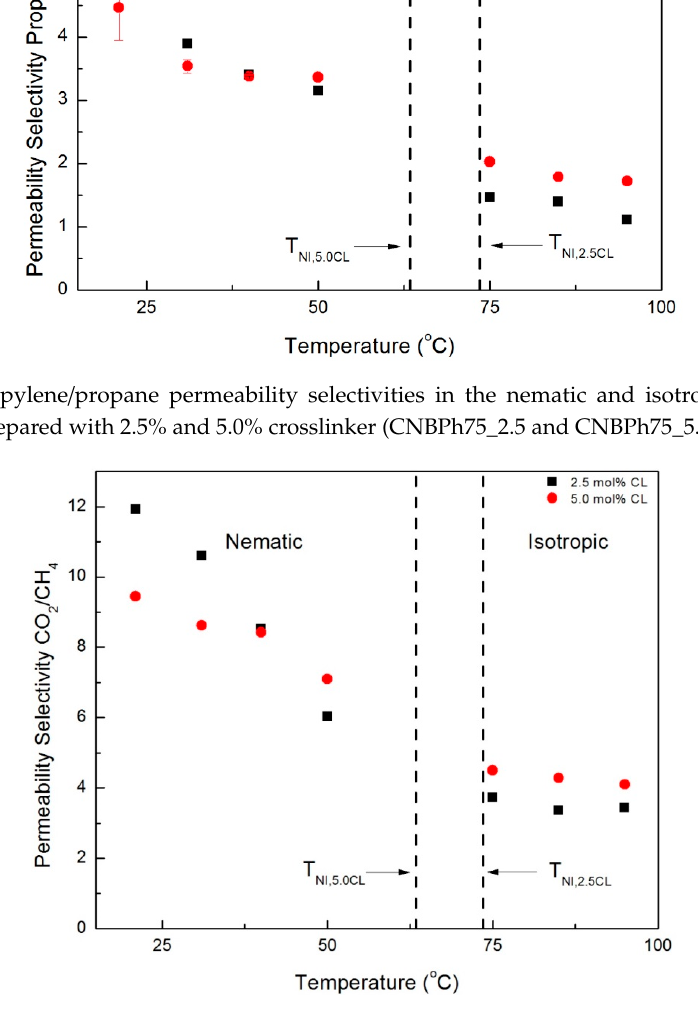
Figure 10. CO 2 /CH 4 permeability selectivities in the nematic and isotropic phases for membranes prepared with 2.5% and 5.0% crosslinker (CNBPh75_2.5 and CNBPh75_5.0).